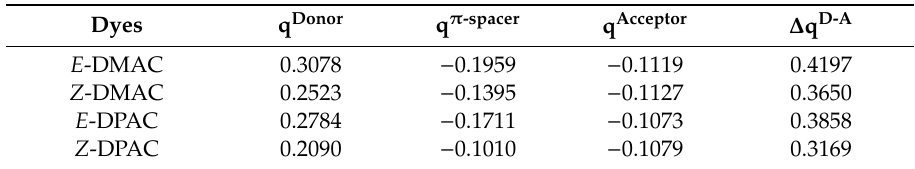
Table 4. NBO analysis results for metal-free organic dyes in the ground state. Here, q Donor , q π -spacer , and q Acceptor denote the total amount of natural charges on the donor group, π -spacer, and acceptor group,